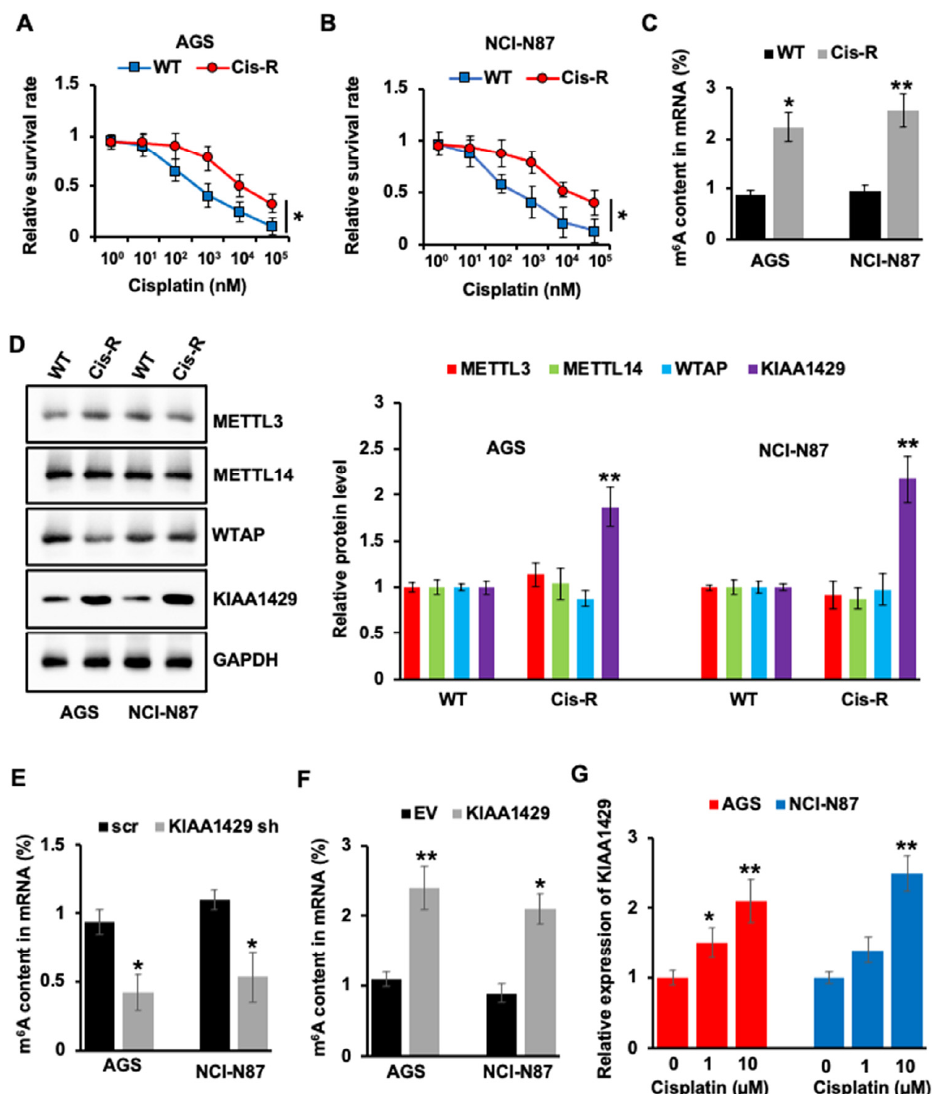
Figure 1. Effect of cisplatin on KIAA1429 expression. ( A , B ) AGS Cis-R (A)/NCI-N87 Cis-R ( B ) and their parental wild type (WT) cells were treated with indicated concentration of cisplatin for 72 h, cell survival was assessed by CCK-8 assay. ( C ) m 6 A quantitative analysis showed the percentage of m 6 A content in AGS Cis-R or NCI-N87 Cis-R and their parental wild type cells. ( D ) The protein level of METTL3, METTL14, WTAP, and KIAA1429 in WT and Cis-R cells were analyzed by Western blotting and densitometric quantification. ( E , F ) m 6 A quantitative analysis showed the percentage of m 6 A content in KIAA1429 shRNA infected ( E ) or KIAA1429 overexpressed cells ( F ). ( G ) Gastric cancer cells were treated with different doses of cisplatin for 48 h, the mRNA level of ki-aa1429 was assessed by QRT-PCR. * p < 0.05, ** p <